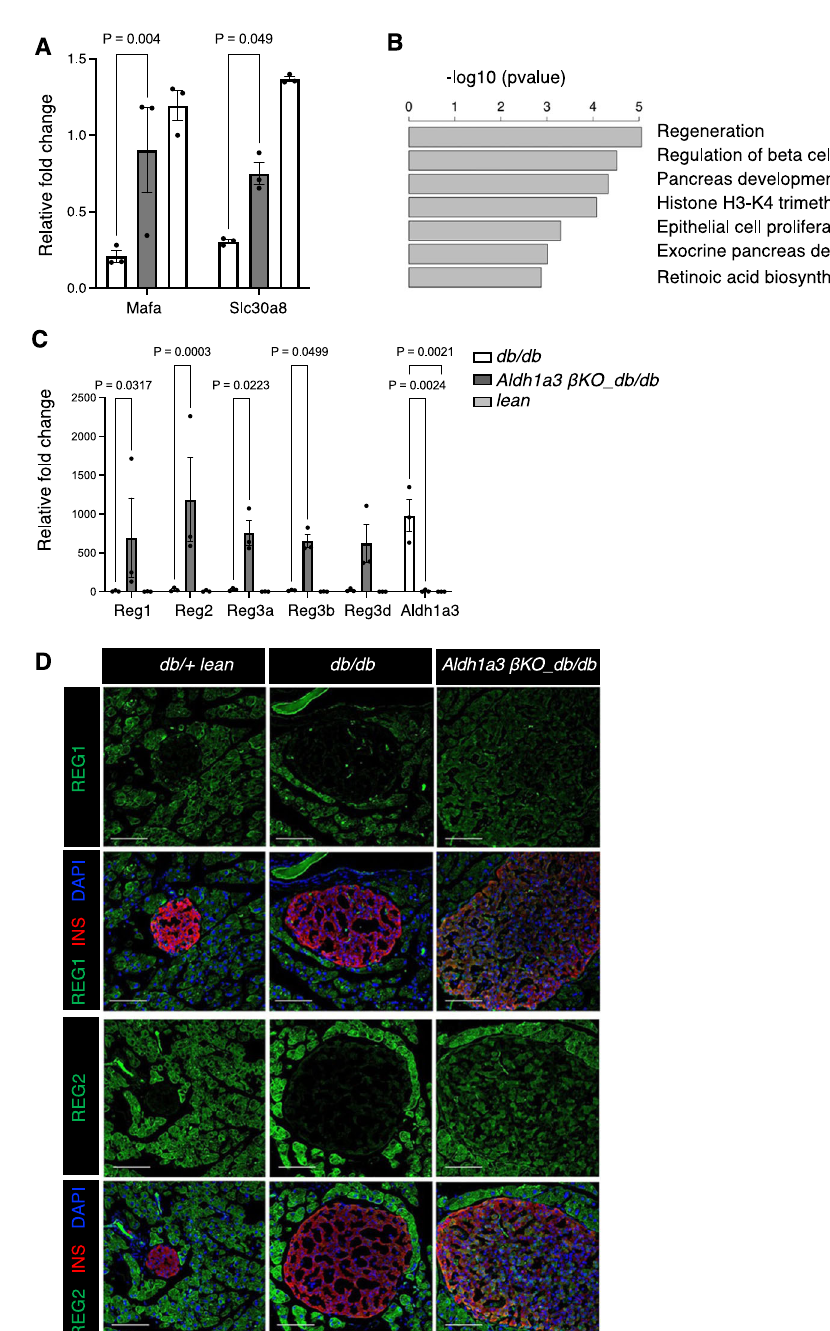
Fig. 5 | RNA expression pathways in Aldh1a3 knockout β -cells. A qPCR analyses ofselectedgenesusingsorted β -cellsfrom β -Aldh1a3KO_db/db ,leanor db/db mice. Results were normalized by the expression of the 18S ribosomal subunit RNA and expressed as fold changes relative to expression levels in lean control. Data are expressed as means±SEM for n =3 biologically independent samples per group. Two-way ANOVA with multiple comparison test was used for statistical analysis. B GO terms of enriched genes in ALDH1A3 knockout β -cells. C qPCR analyses as in